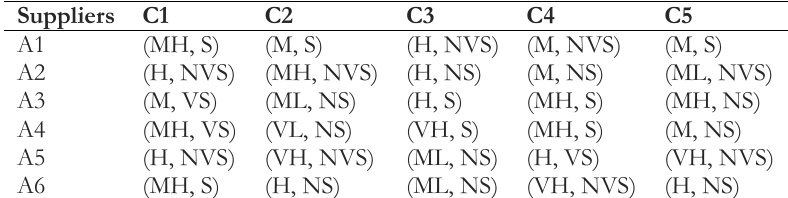
Table 5. Linguistic preferences of Expert 3